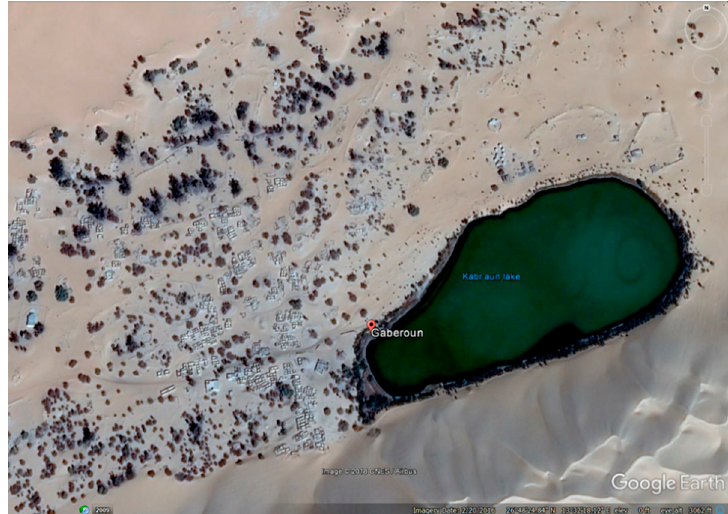
Figure 7. Gaberoun Oasis, a large lake in the Idehan Ubari desert region of the Fezzan region in southwestern Libya, with a rudimentary tourist camp, complete with a handful of sleeping huts and a small market [49].